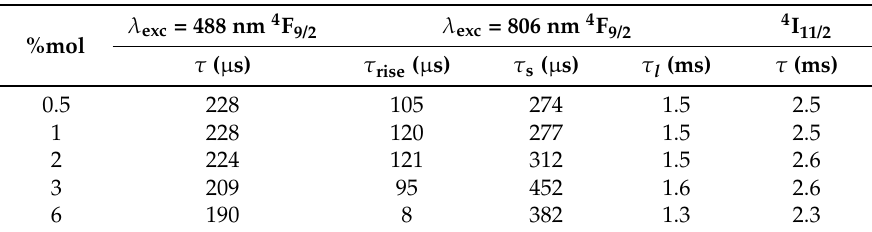
Table 3. Lifetime values of the 4 F 9/2 level obtained under excitation at 488 nm and 806 nm together with the lifetime values of the 4 I 11/2